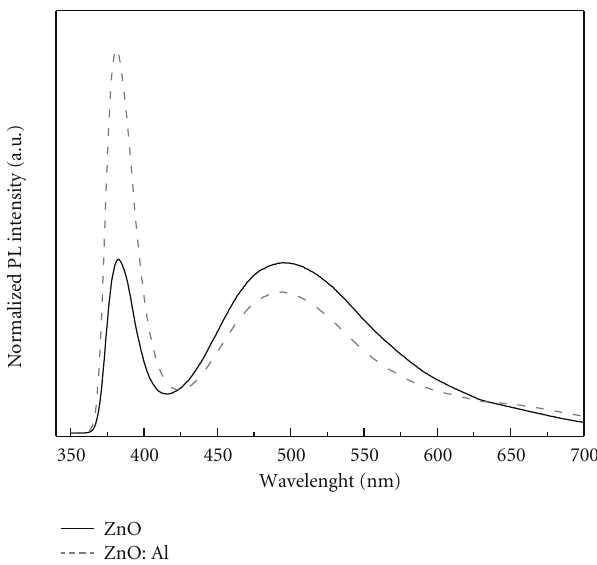
Figure 6: Normalized photoluminescence of ZnO and ZnO: Al films.